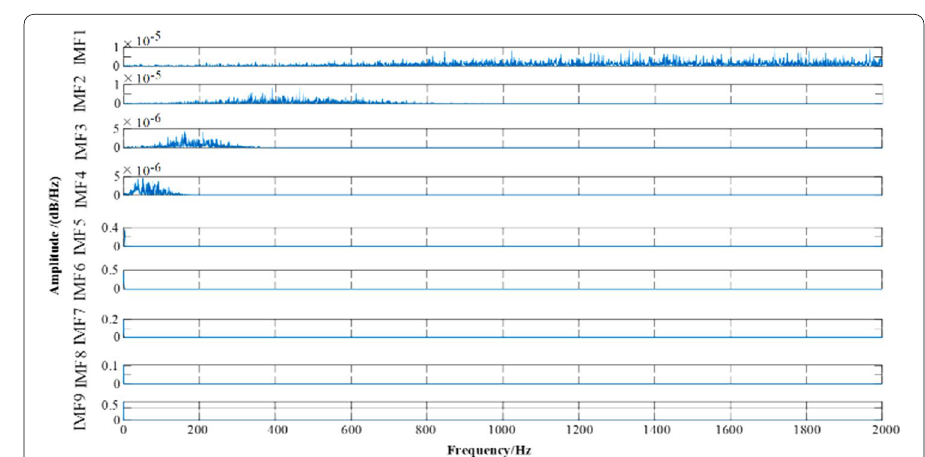
Fig. 14 Spectral of received signal IMFs (SNR